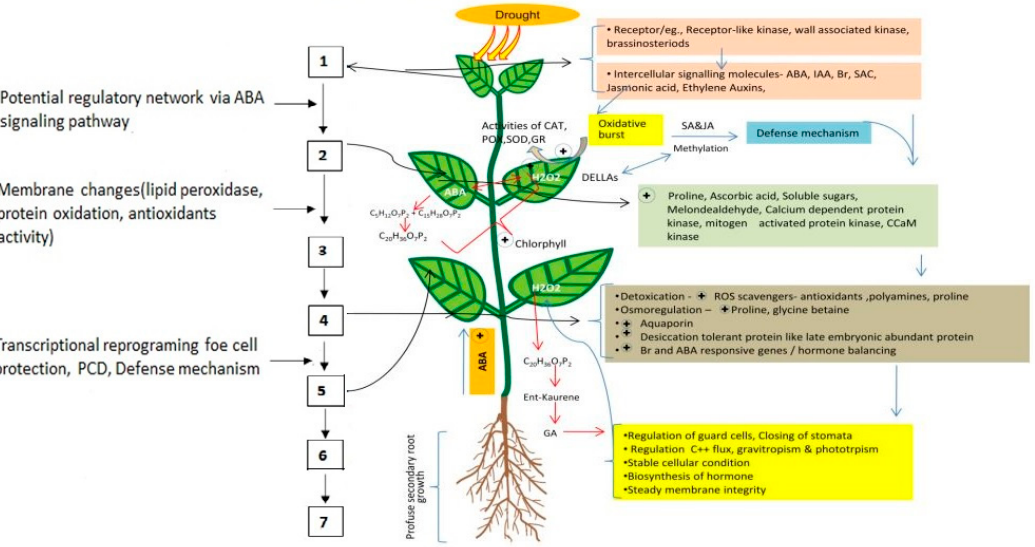
Figure 1. Schematic representation of drought response and stress tolerance mechanism. 1—Signal perception; 2—Cell signaling (signal transduction); 3—Transcriptional regulation; 4—Expression on regulation of stress responsive genes & cytoplasm protein transduction; 5—Respond to signal; 6—Cellular response; 7—Enhanced drought stress tolerance.